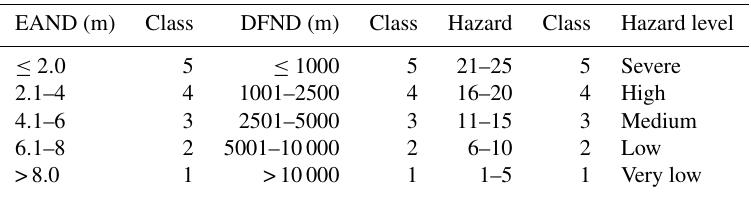
Table 1. Classes of elevation above nearest drainage (EAND), distance from nearest drainage (DFND), and the resultant flood hazard for Canada. EAND